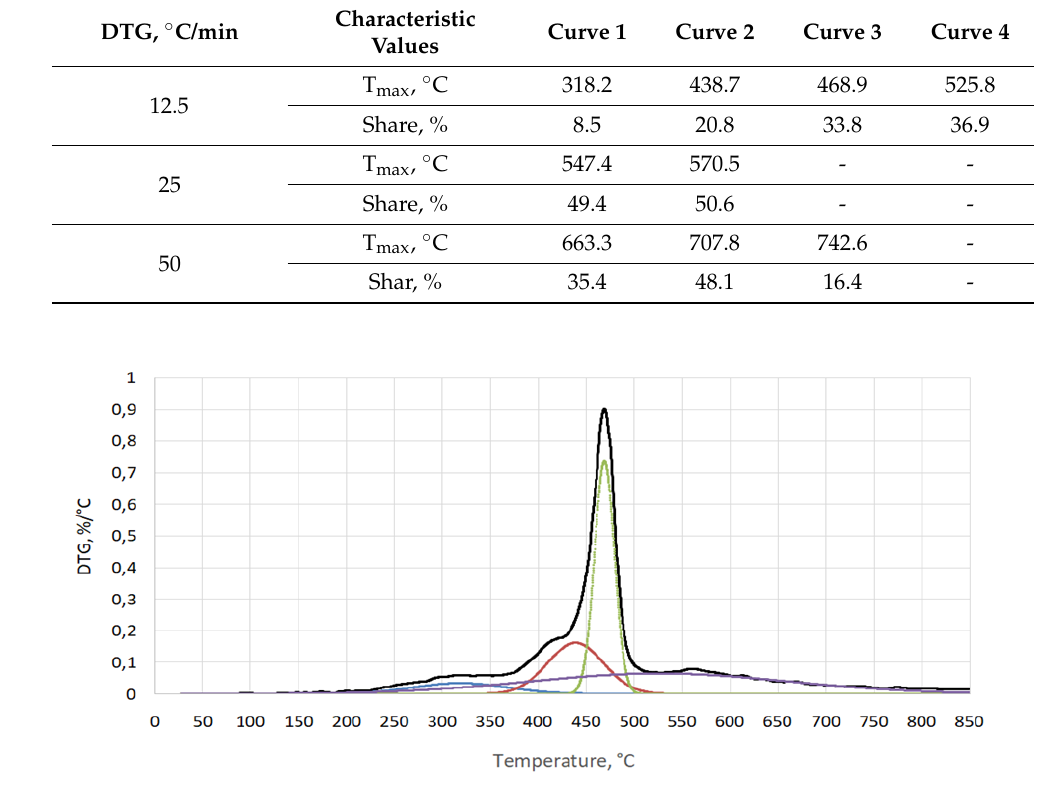
Table 3. Characteristic values of DTG curves for different heating rates.